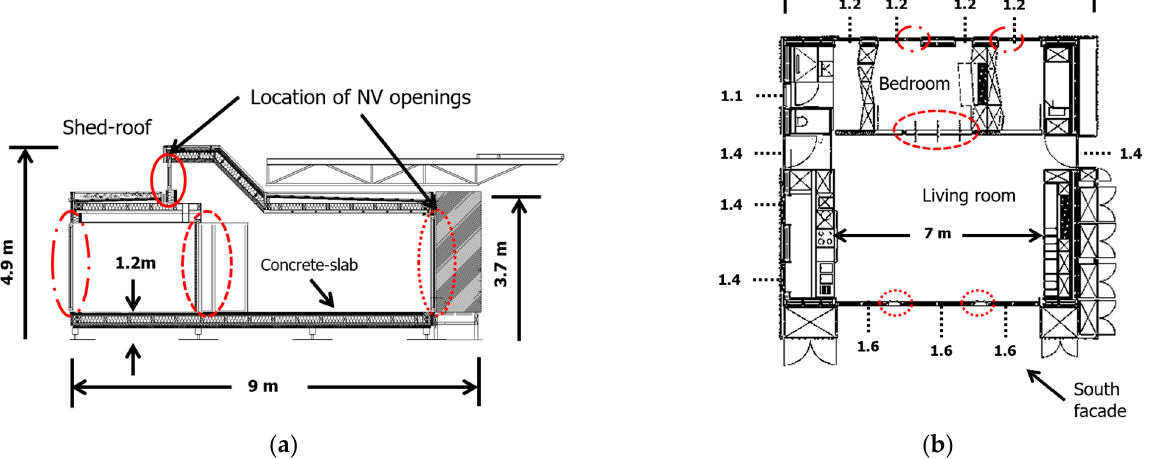
Figure 2. Schematic of the architectural plan of the building: ( a ) western view and ( b ) top view. Values of the global heat transfer coefficients for external walls of the platform (dotted lines).